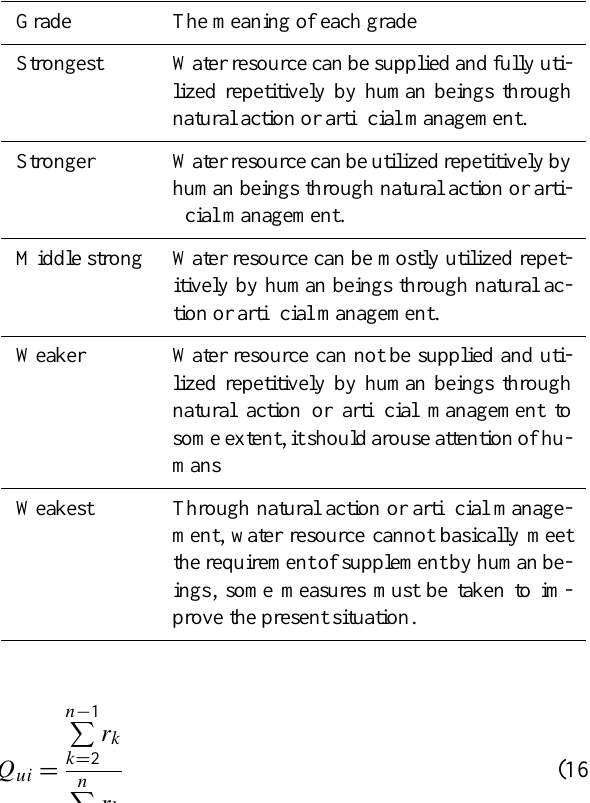
Table 2. The meaning of each grade for water resource renewability